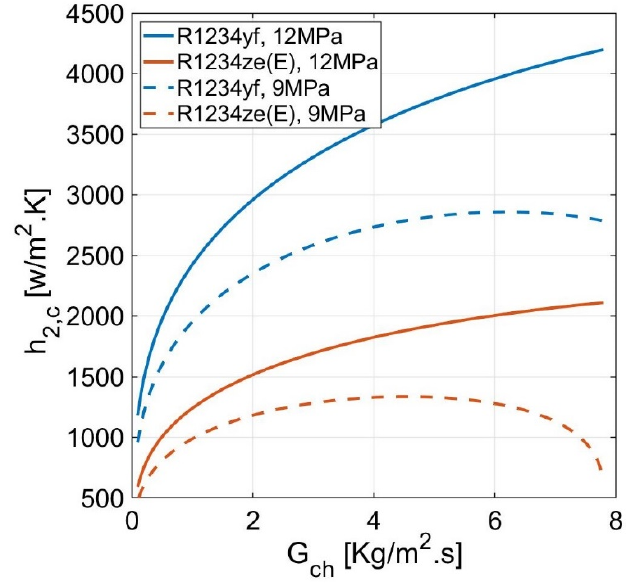
Figure 6. Cold stream liquid-phase and gas-phase convection coefficients at various cold channel mass fluxes.